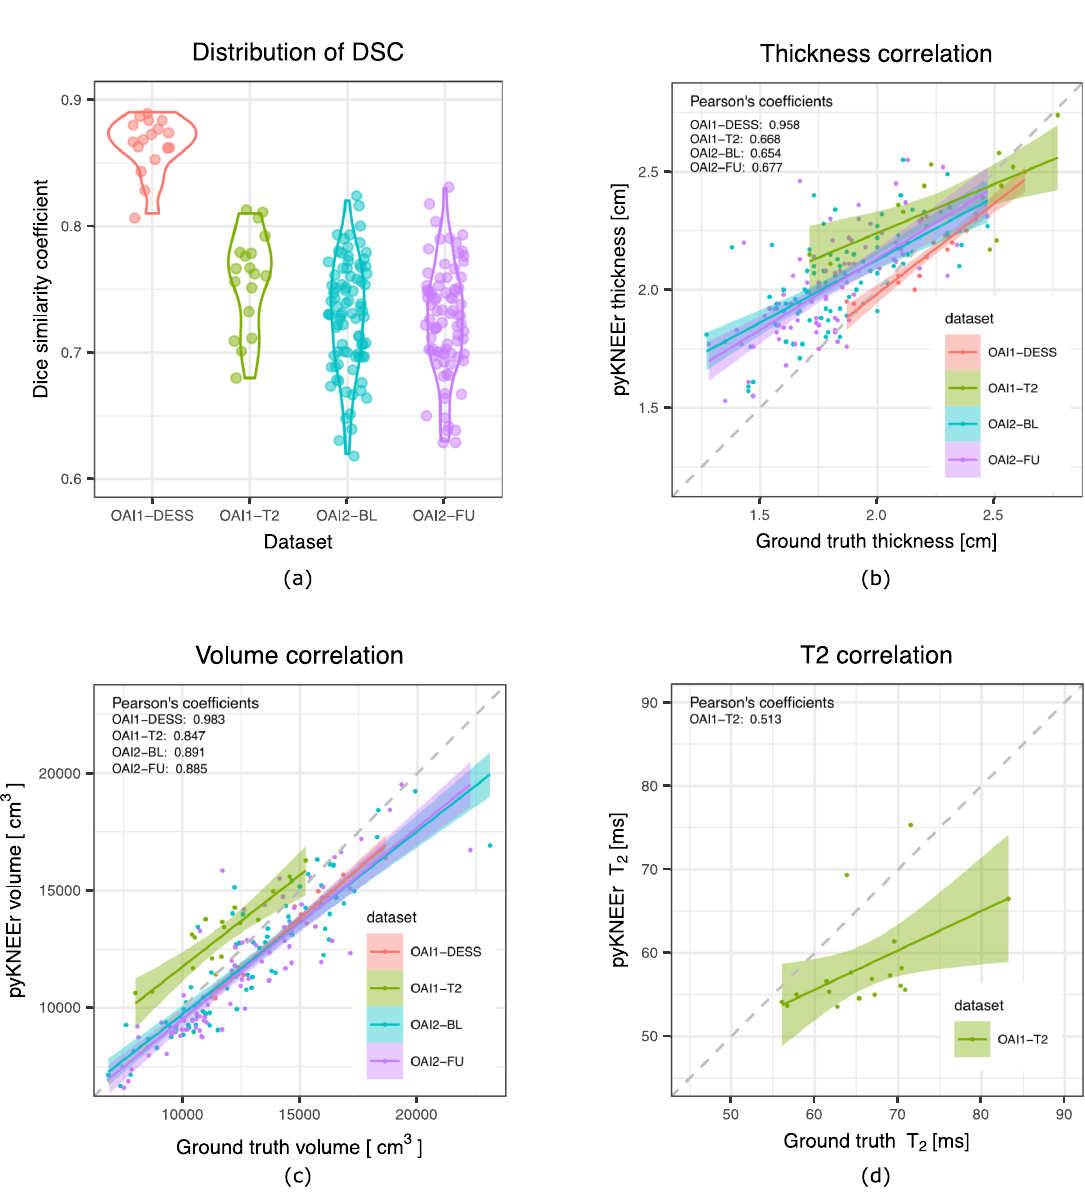
Fig 4. Results for the datasets OAI1-DESS (red), OAI1-T2 (green), OAI2-BL (cyan), and OAI2-FU (purple). (a) Violin plots describing the distribution of the DSC within each dataset. The dots represent DSC values spread around the y-axis to avoid visualization overlap. (b-d) Correlation between measurements derived from ground truth segmentations and pyKNEEr ’s segmentations, i.e. cartilage thickness (b), cartilage volume (c), and T 2 maps (d). (See data, code, computational environment).